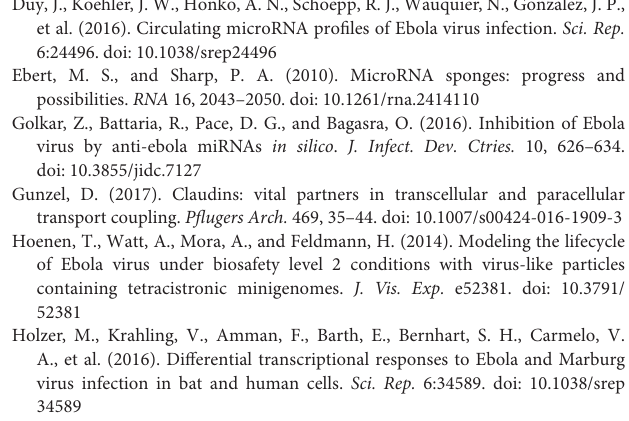
Table S1 | Differentially expressed non-coding RNAs. Table S2 | Differentially expressed circular RNAs. Table S3 | Differentially expressed messenger RNAs. Table S4 | Differentially expressed micro RNAs. Table S5 | Choosen genes for co-expression network and ceRNA analysis. Table S6 | ceRNA network (circRNA). Table S7 | ceRNA network